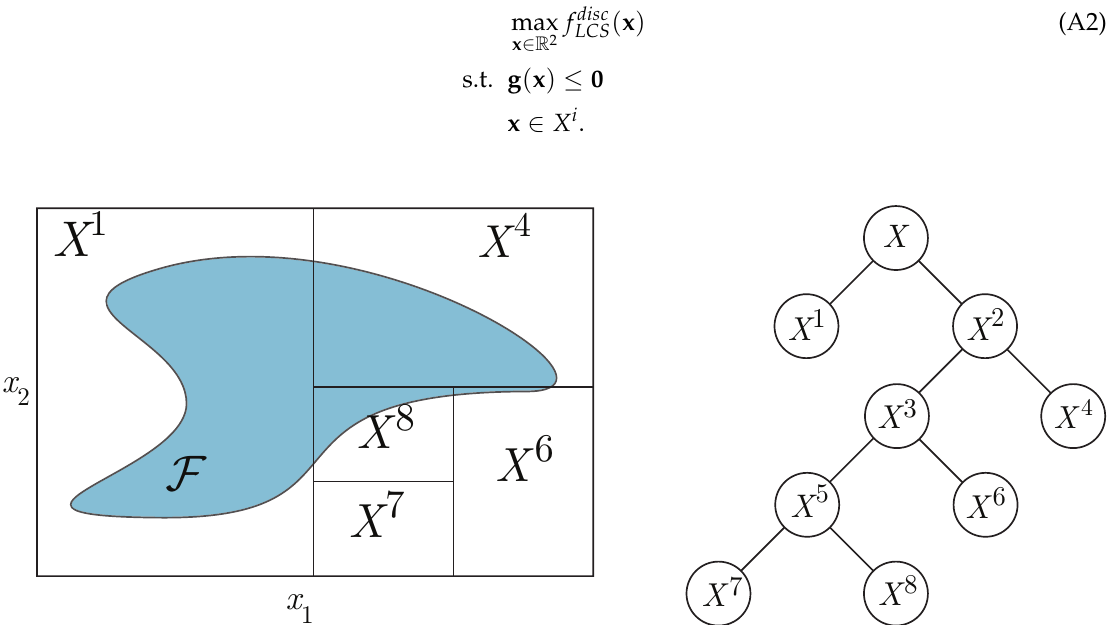
Figure A1. ( Left ) The decision space X (outer box) is shown overlaying the feasible set F and is partitioned into subintervals using a bisection strategy. Note that X 7 ∩ F = ∅ and therefore the corresponding upper- and lower-bounding problems are infeasible. ( Right ) An illustration of the B&B tree corresponding to the decision space